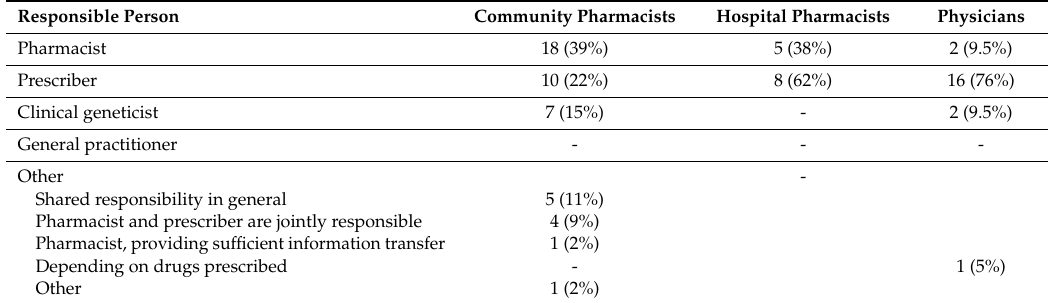
Figure 3. The steps which community pharmacists reported they would take after having received pharmacogenomic screening results. Table 2. Final responsibility for the application of pharmacogenomic screening results in patient care.